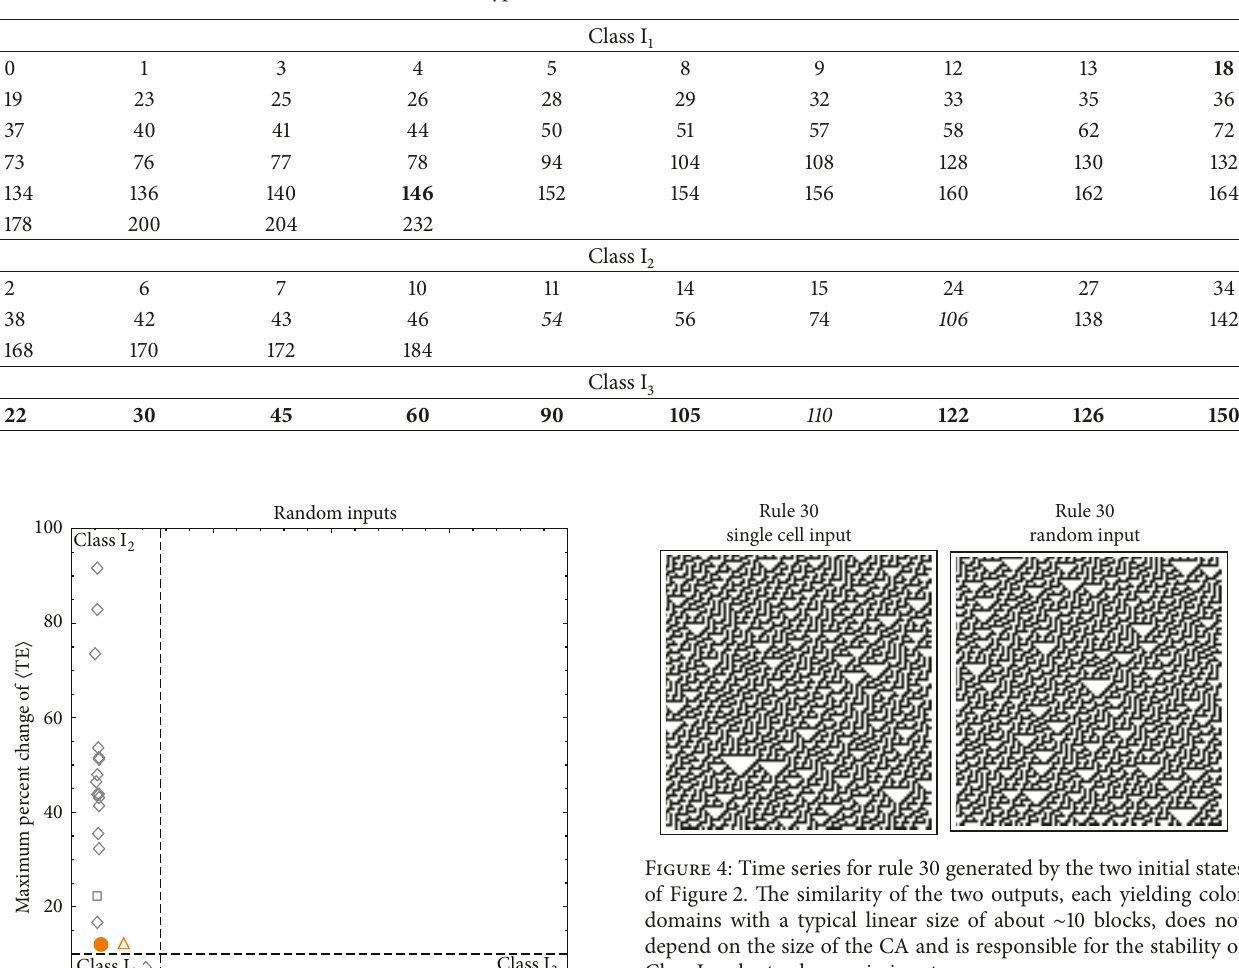
Table 2: Information based classification of ECA, with only the 88 rule equivalence classes shown (represented by the lowest number rule). Wolfram Class III rules are denoted in black, boldface type, and Class IV in italic.